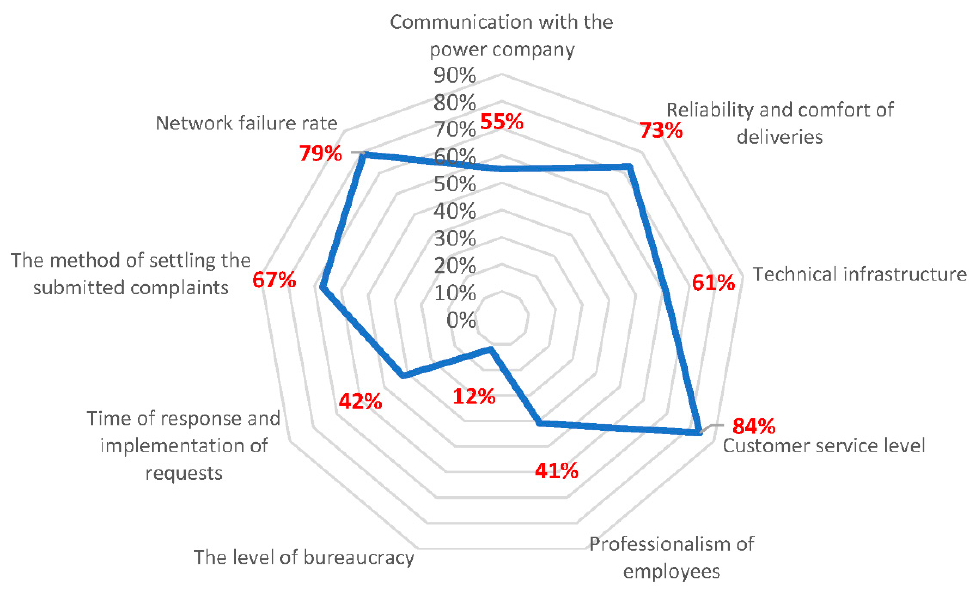
Figure 3. Factors determining the quality of services provided by energy companies .